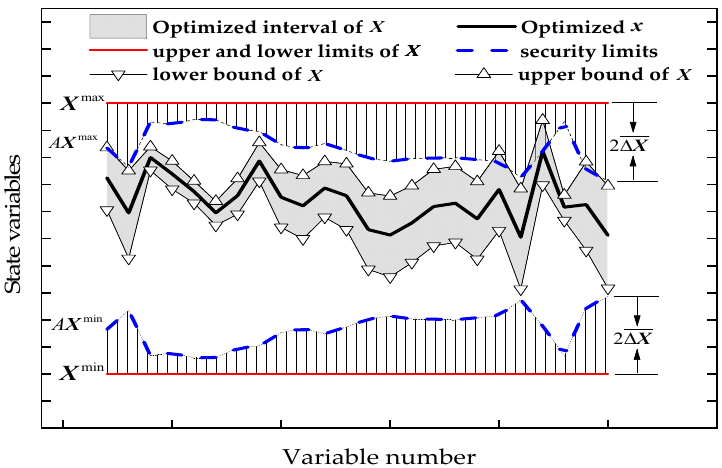
Figure 2. Absolute security limits and optimized interval variable results.